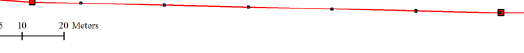
Figure 4. Tunnel axis with the original points (larger squares) and the equally spaced points (small dots).